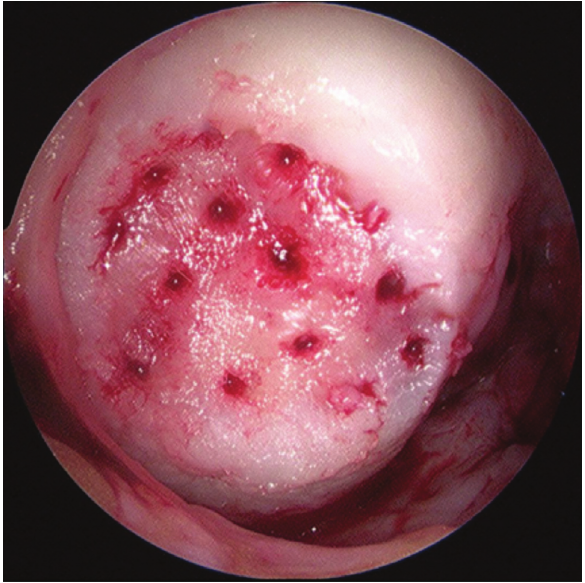
Fig. 3: Arthroscopy image. Dry arthroscopy after completion microfracture.